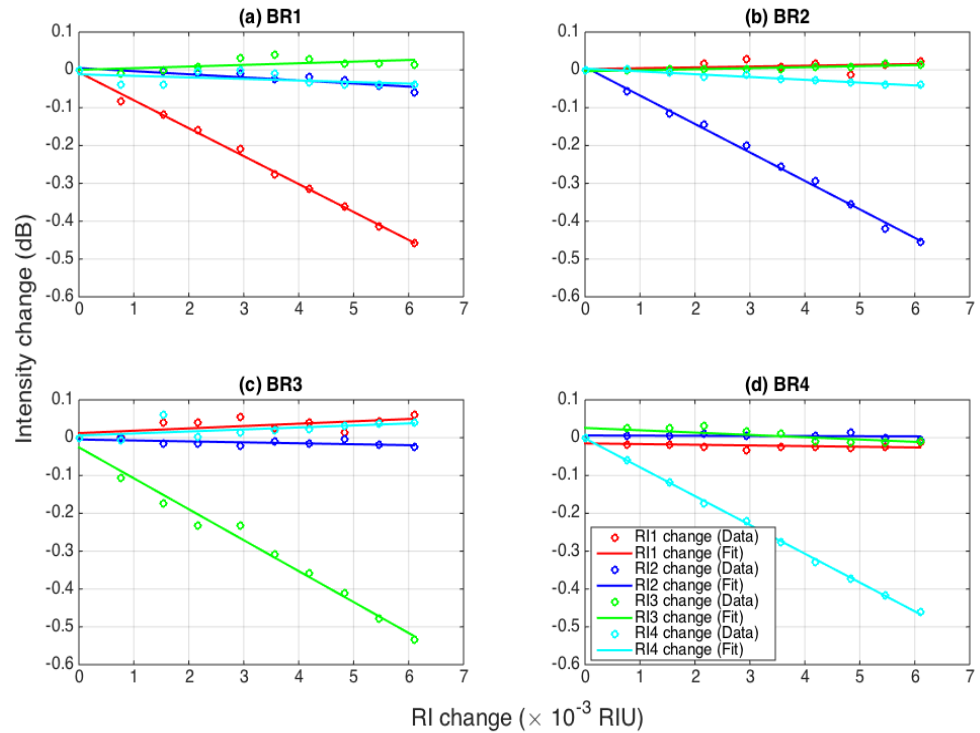
Figure 6. Evaluation of the intensity change for each ball resonator sensor as a function of the RI, within the multiplexed sensing network. The charts show the intensity change for each BR sensor: ( a ) BR1, ( b ) BR2, ( c ) BR3, and ( d ) BR4. Each curve shows the response of the sensor when the RI changes (from 0 to 6.1 × 10 − 3 RIU) for one sensor, while the other RI values remain constant: red = BR1 RI changes; blue = BR2 RI changes; green = BR3 RI changes; cyan = BR4 RI changes. Measured data are reported as circles; linear fits are reported as solid lines.